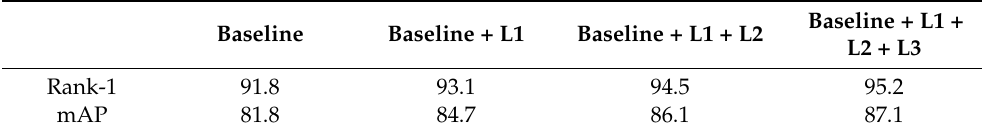
Table 2. Comparison of ablation experiment results (Market1501).